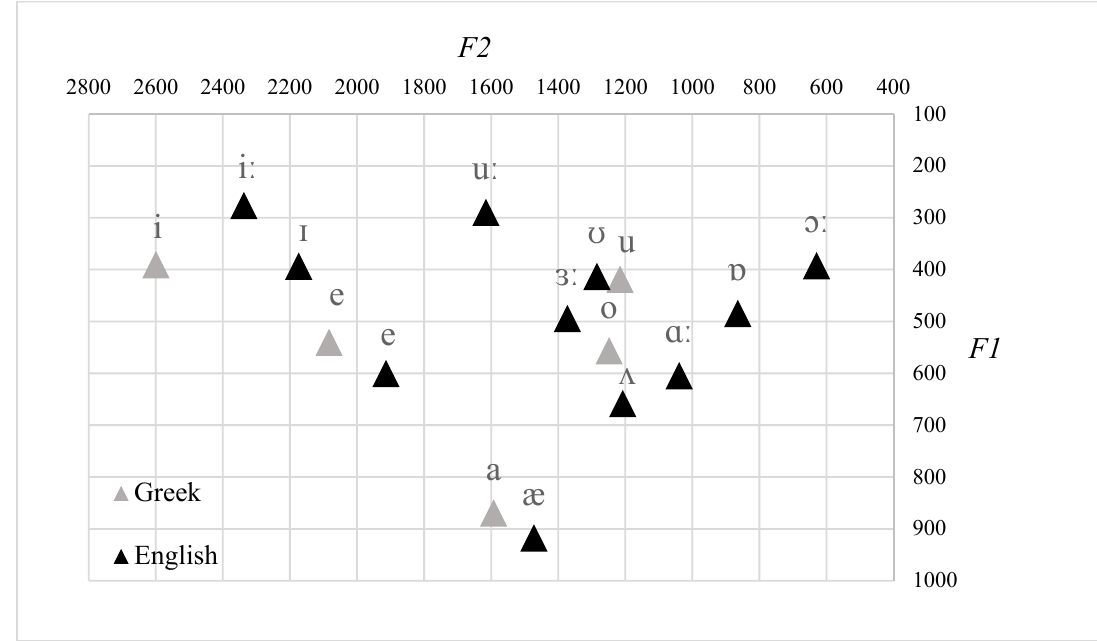
Figure 1. F1 × F2 of the (Cypriot) Greek and English (Timberlake 2004) vowels as produced by their respective adult native speakers.